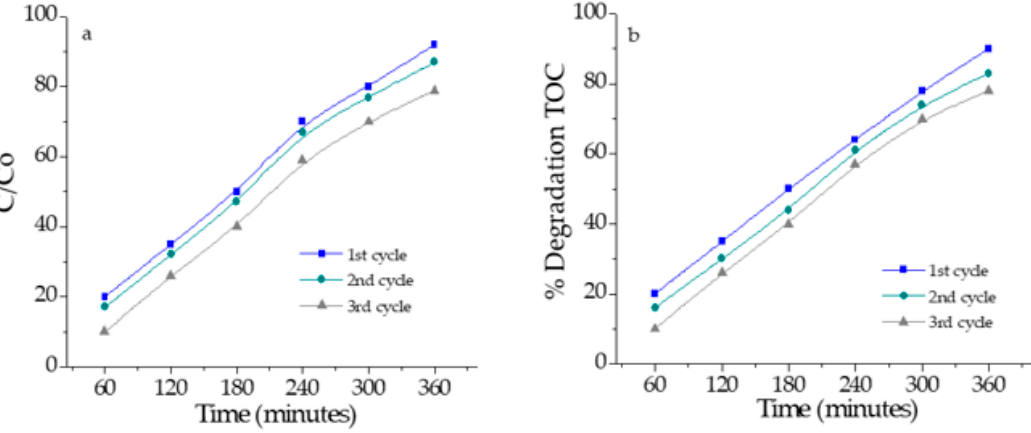
Figure 11. ( a ) Catalyst reuse study with UV-Vis spectroscopy. ( b )TOC analysis .